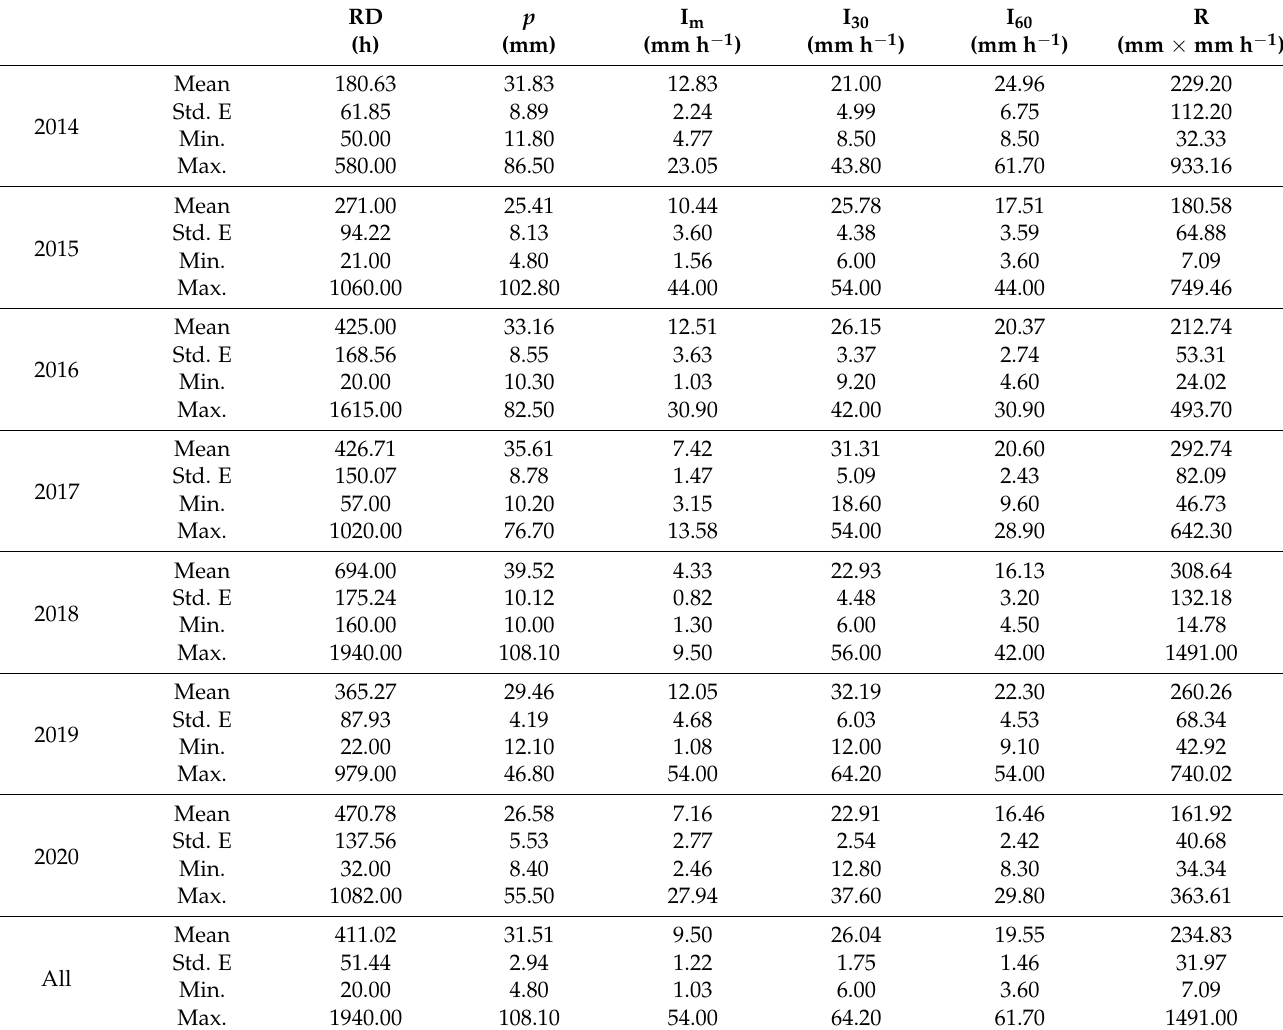
Table 2. Statistical characteristics of the five rainfall eigenvalues and rainfall erosivity for the 66 erosive rainfall events